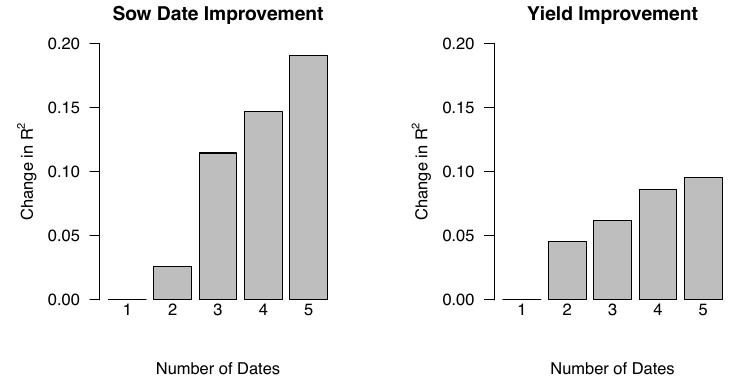
Figure 3. Change in R 2 by adding an additional image date for the 2015–2016 study season using crop cuts as calibration data. Each image date was added from most to least important based on variable importance measures from random forest